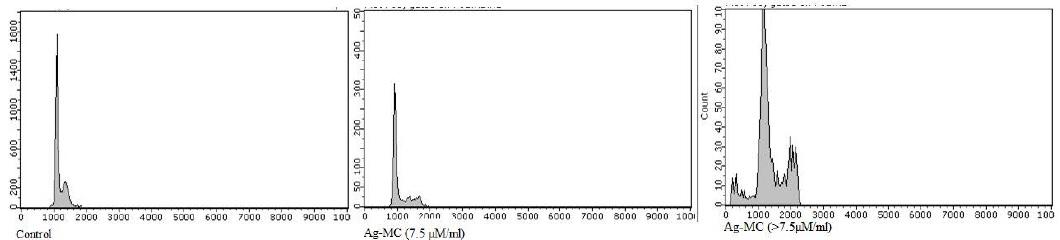
Figure 9. Effect of Ag-MC on Protein expression of NF-k β family proteins. ( a , b ) E ff ect of Ag-MC on protein expression of NF-k β family proteins.